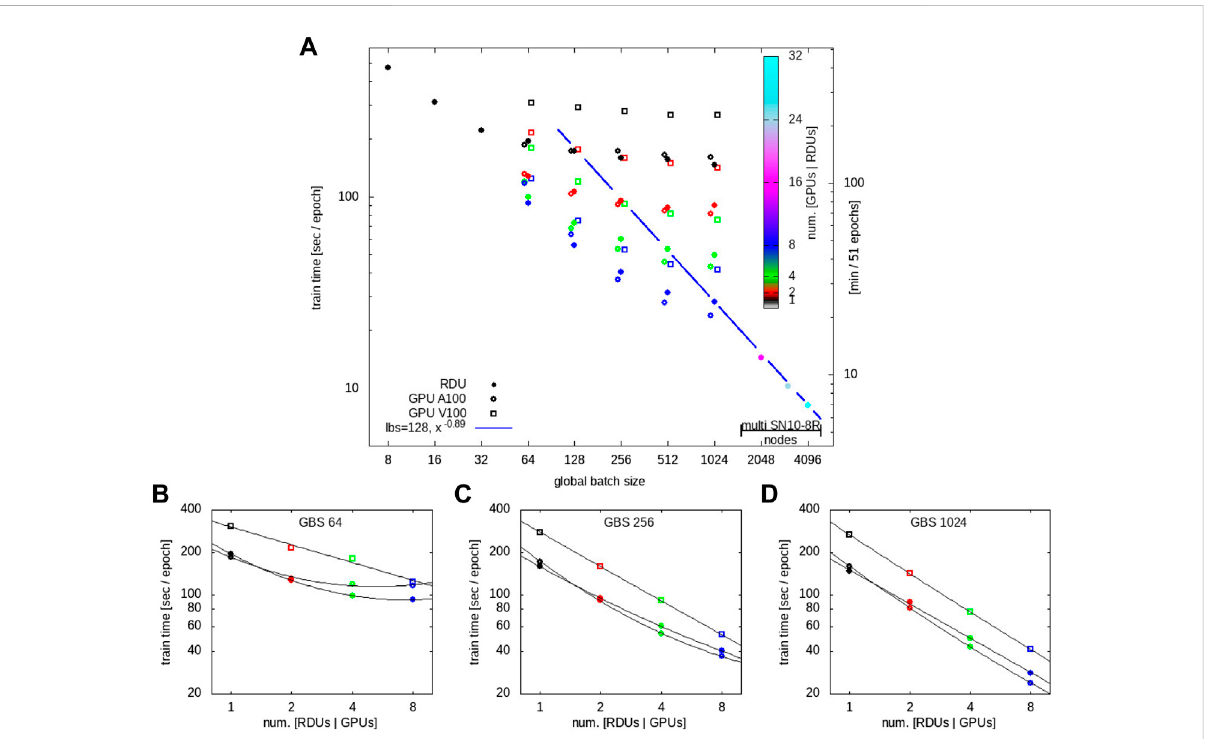
FIGURE 3 (A) . Per epoch training time versus the global batch size (GBS). The number of accelerators used for data-parallel training is represented by symbol color as indicated in panel A: 1 = black, 2 = red ... 32 = cyan. Note that we have added a slight “ jitter ” shift around the x -axis value for ease of data point visibility — all GBSs and number of devices are indeed integer powers of 2. The thick blue line indicates that, for a constant LBS of 128, increasingthenumberofRDUsscalesthetrainingtimeas x − 0.89 .ThattheV100(opensquares)lineupwithA100(opencircles)withacoloroffset of one (a doubling) indicates that for this workload the A100 generally performs twice as fast as the equivalent V100 condition. (B – D) . Training time versus number of accelerators for GBSs of 64, 256, and 1024 as indicated with symbol color remaining consistent with panel A convention.